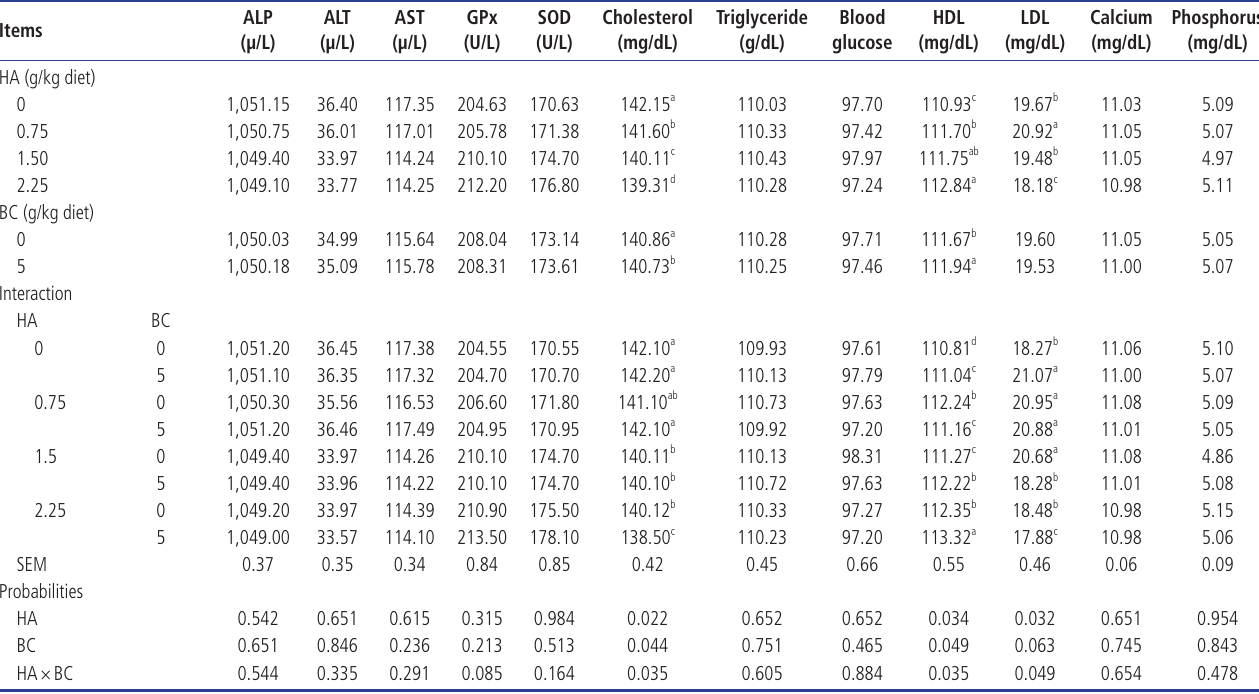
Table 5. Effect of dietary treatments on blood serum chemistry of quail Items